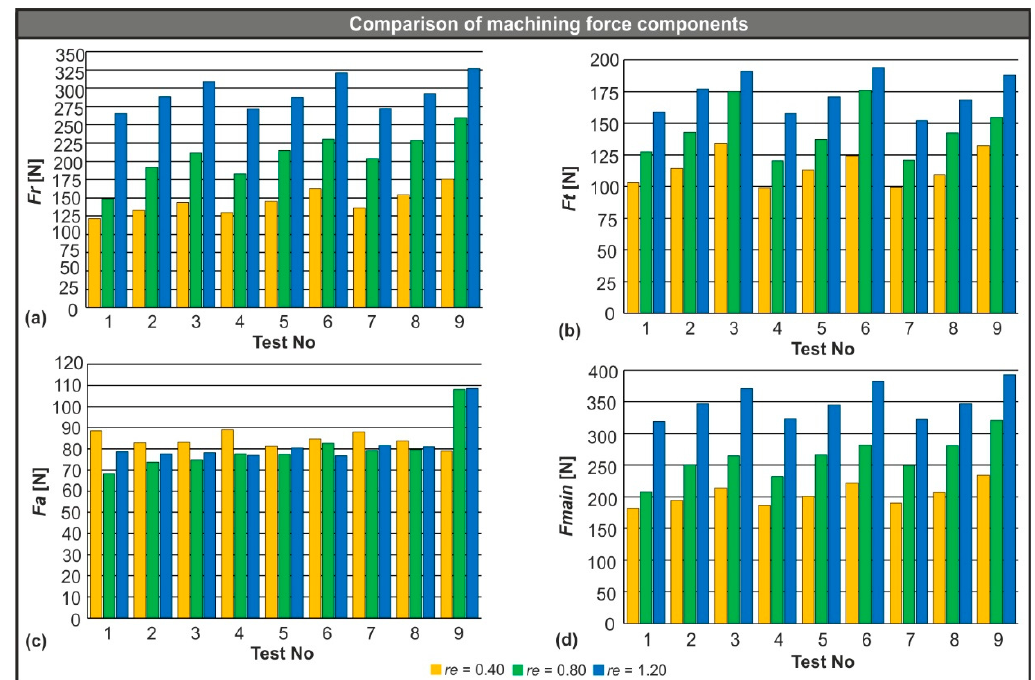
Figure 6. ( a ) Comparison of the radial force, ( b ) the tangential force, ( c ) the feed force, and ( d ) the resultant machining force based on the different nose